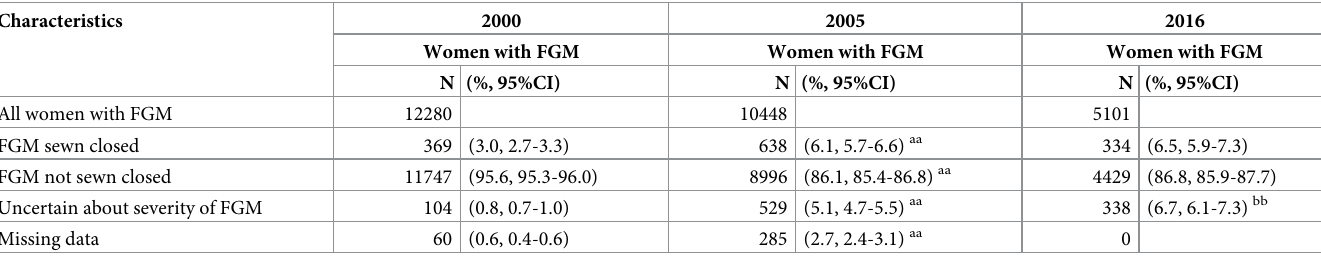
Table 2. Severity of female genital mutilation (FGM) in Ethiopian women: 2000, 2005 and 2016.